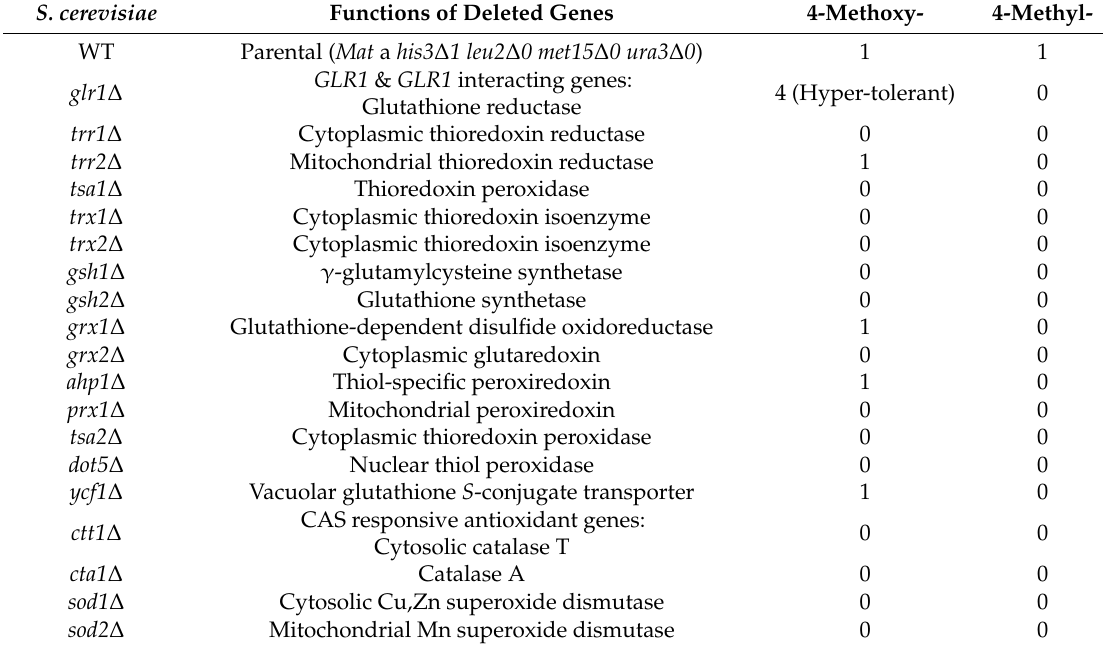
Table 2. Responses of S. cerevisiae WT and gene deletion mutants to 4-methoxy- or 4-methylcinnamic acid (0.5